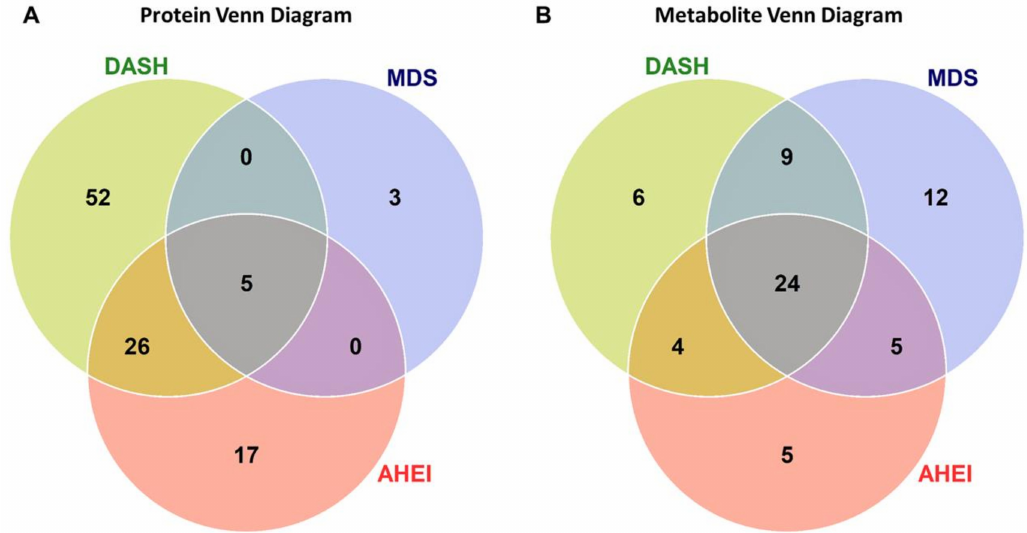
Figure 1. The number of protein ( A ) and metabolite ( B ) markers associated with dietary pattern indices. Venn diagrams illustrate the overlap of significant proteins (FDR q ≤ 0.05) and metabolites across the AHEI, DASH, and MDS dietary patterns. Significant proteins and metabolites were based on a false discovery rate threshold ≤ 0.05 from multivariable models adjusted for age, sex, total caloric intake, current smoking, physical activity index, lipid lowering medication, anti-hypertensive medication, and body mass index. Abbreviations: AHEI, Alternative Healthy Eating Index; DASH, Dietary Approaches to Stop Hypertension; FDR, false discovery rate; MDS, Mediterranean-style Diet